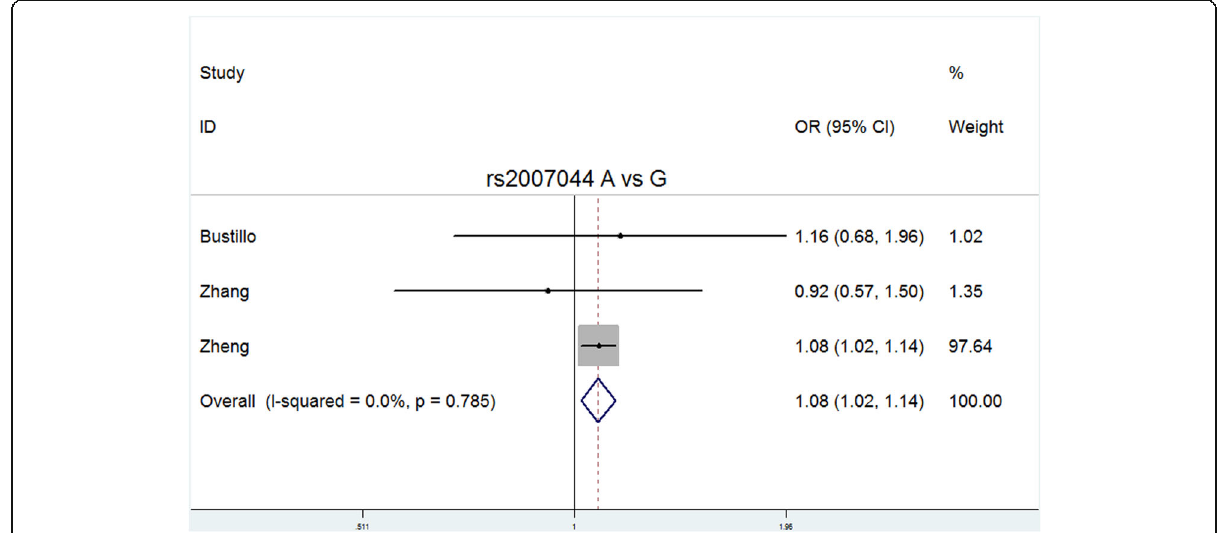
Fig. 8 Forest plot of the allele contrast model (A vs. G) for rs2007044. Significant differences between rs2007044 and the risk of schizophrenia were observed with the allele contrast model (A vs. G) (OR = 1.080, 95% CI = 1.023 – 1.139, P heterogeneity = 0.785, P = 0.006)